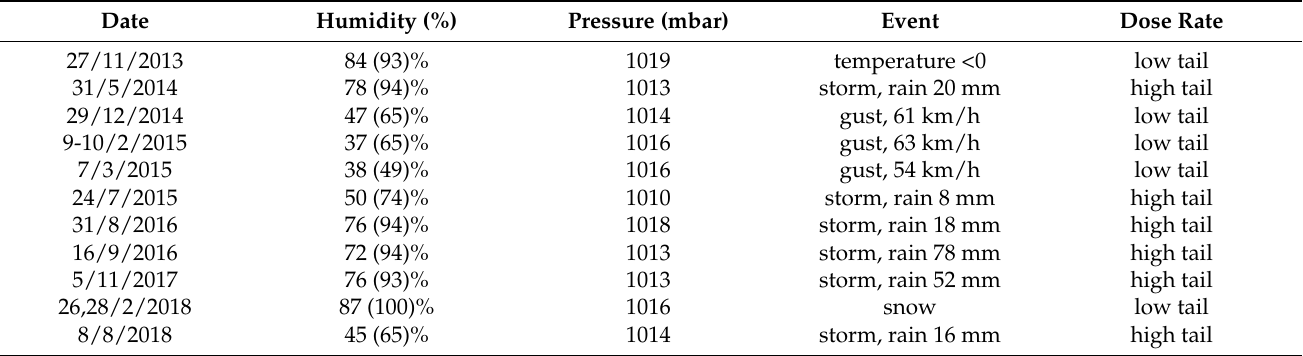
Table 1. Meteorological conditions at the measurement site for the days when dose rate registered values show large residual . The humidity values reported in the table are the average (first) and the maximum (in parenthesis). The last column reports where the dose rate data fall in the distribution, either in the low or high dose rate tail.